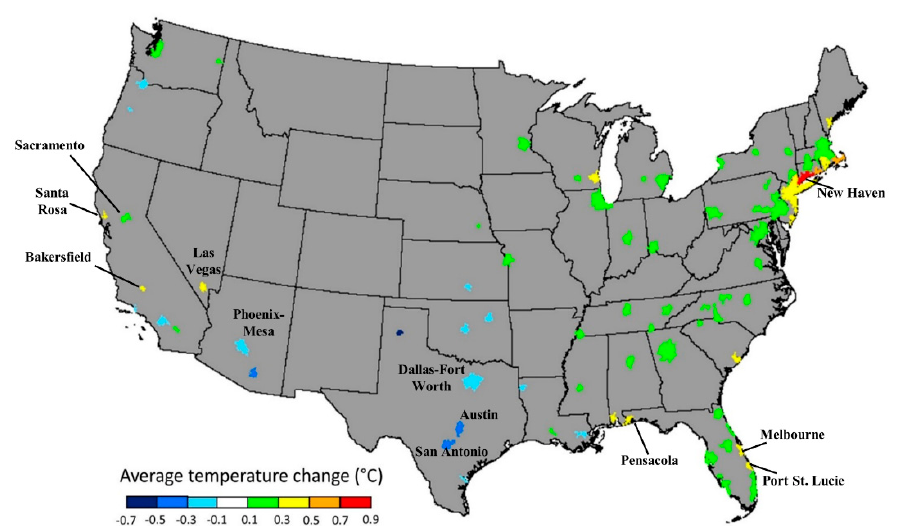
Figure 3. Summer surface temperature change ( ◦ C) between 2001 and 2011 due to urban-induced land cover change only. For plotting purposes, we represent urban centers with areas larger than 5000 ha and ISA greater than 5% (see text for details).